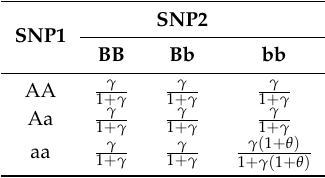
Table 3. Penetrance table of the recessive-recessive